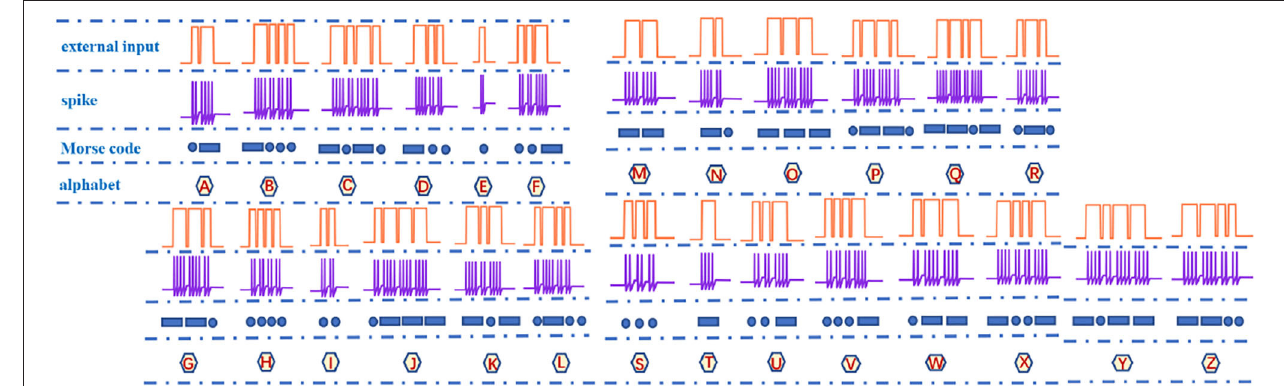
FIGURE 10 | The correspondence relationship of letters, spikes, and Morse codes.